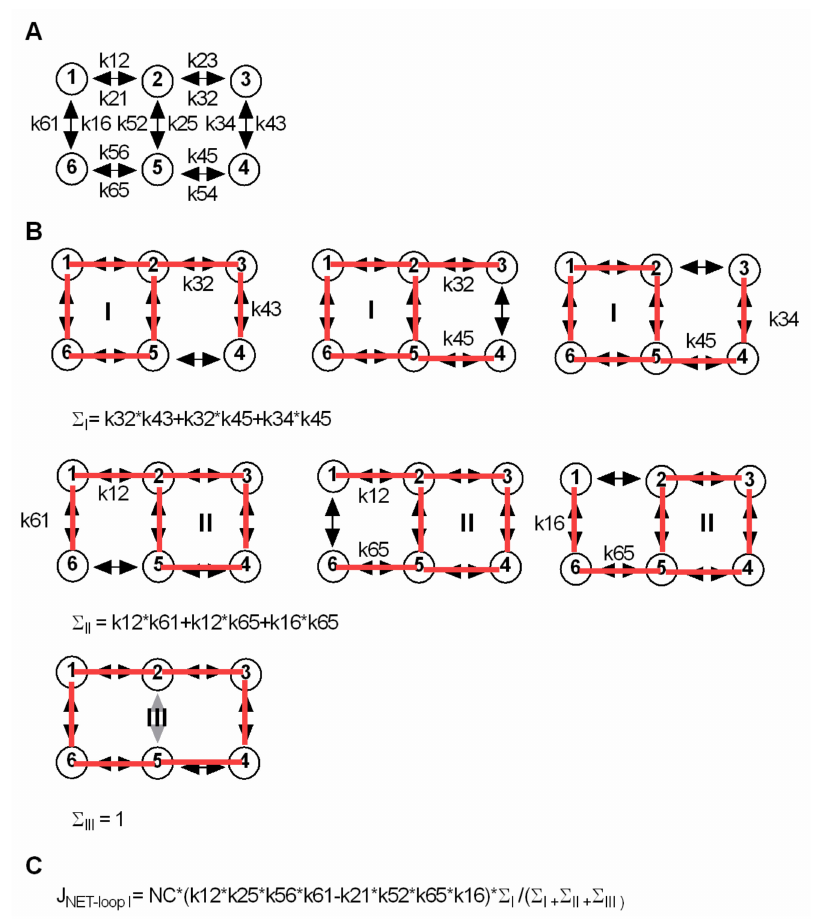
Figure 6. Analytical approach to calculate the intra- and extracellular substrate concentrations at steady state for a kinetic model in which the driving ion and the substrate are loosely coupled. ( A ) Shows a simple scheme, identical to the scheme in Figure 2A. ( B ) Approach to calculate the net flux through a loop within a kinetic model. The scheme has three loops I, II and III. In B , we show how to derive the equation for the net flux through loop I (J NET-loopI ). In the upper row we depict the longest possible paths to enter loop I. Each of these paths is one transition short of closing a second loop. Finding these (cid:80) paths is necessary to obtain I: the rates in each individual path are multiplied, and the rates of di ff erent (cid:80) paths are summed. The same approach applies to loop II (middle row). III is 1, because no path exists, which would not immediately close a second loop. ( C ) Equation for the net flux through loop A. NC is the number of transporters, which in the equation is multiplied with the product of the rates in loop I in the forward direction, minus the product of the rates of loop I in the reverse direction. The net flux through loops II and III can be derived in an analogous manner. The intra- and extracellular substrate concentrations at steady state can be found by solving for the substrate concentrations at which the net flux trough loop II equals the net flux through loop III. This is the condition at which there is no net flux of substrate through the transporter (i.e., steady